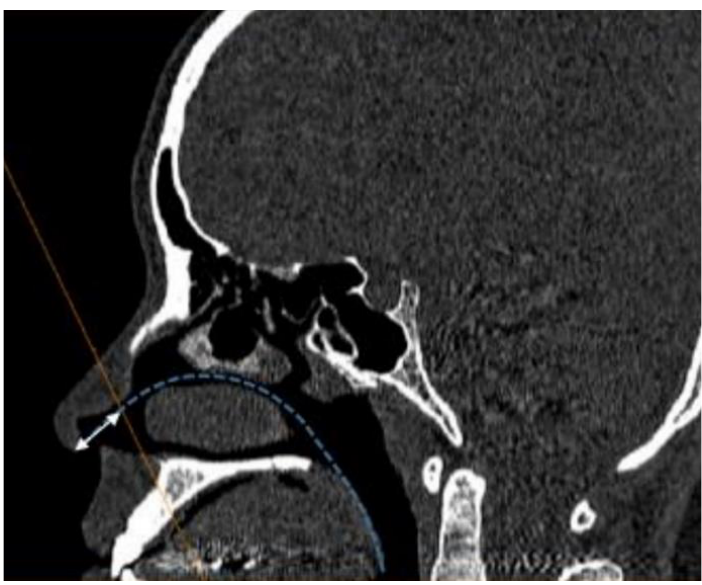
Figure 1. Identification of the plane perpendicular to the imaginary acoustic axis. Dotted blue line: the imaginary acoustic axis; white double-headed arrow: the distance from the nostril to the internal nasal valve (INV) obtained through AR; orange line: the plane perpendicular to the imaginary acoustic axis.